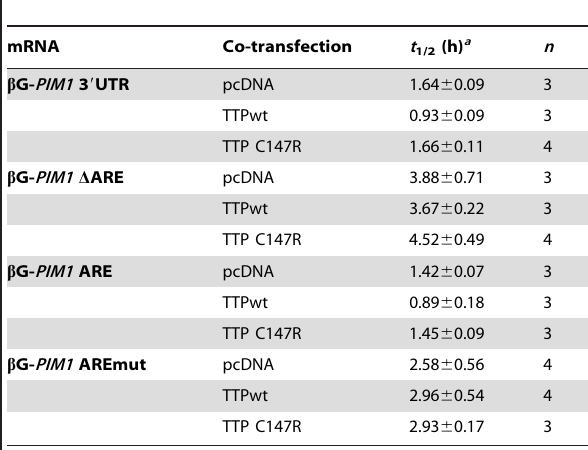
Table 2. Decay kinetics of b G- PIM1 chimeric mRNAs in transfected HeLa